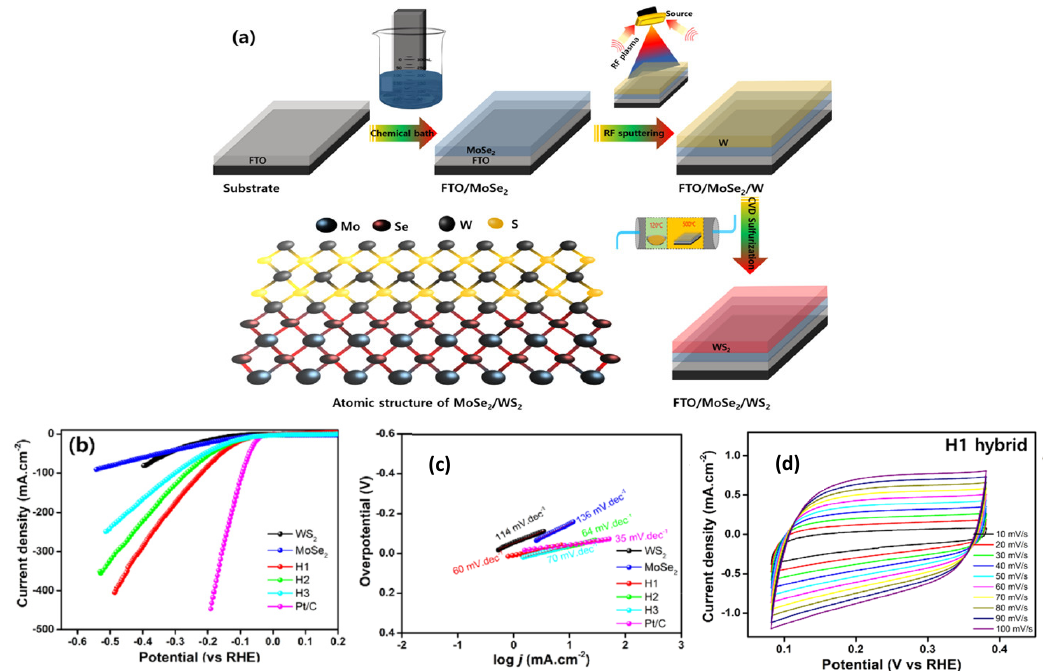
Figure 10. ( a ) Illustration diagram of the synthesis process of the heterostructure. ( b , c ) LSV and Tafel plots of WS 2 , MoSe 2 , and different hybrid junctions of them, respectively. ( d ) Cyclic voltammetry profiles of MoSe 2 /WS 2 heterostructure at different sweep rates. Reproduced with permission. [144] Copyright 2021, American Chemical Society.